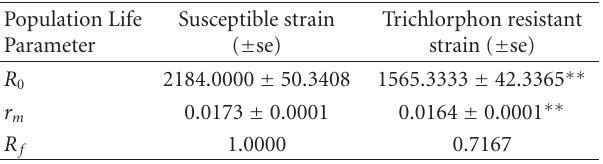
Table 4: The life-history traits and relative fitness of two strains of B. dorsalis.